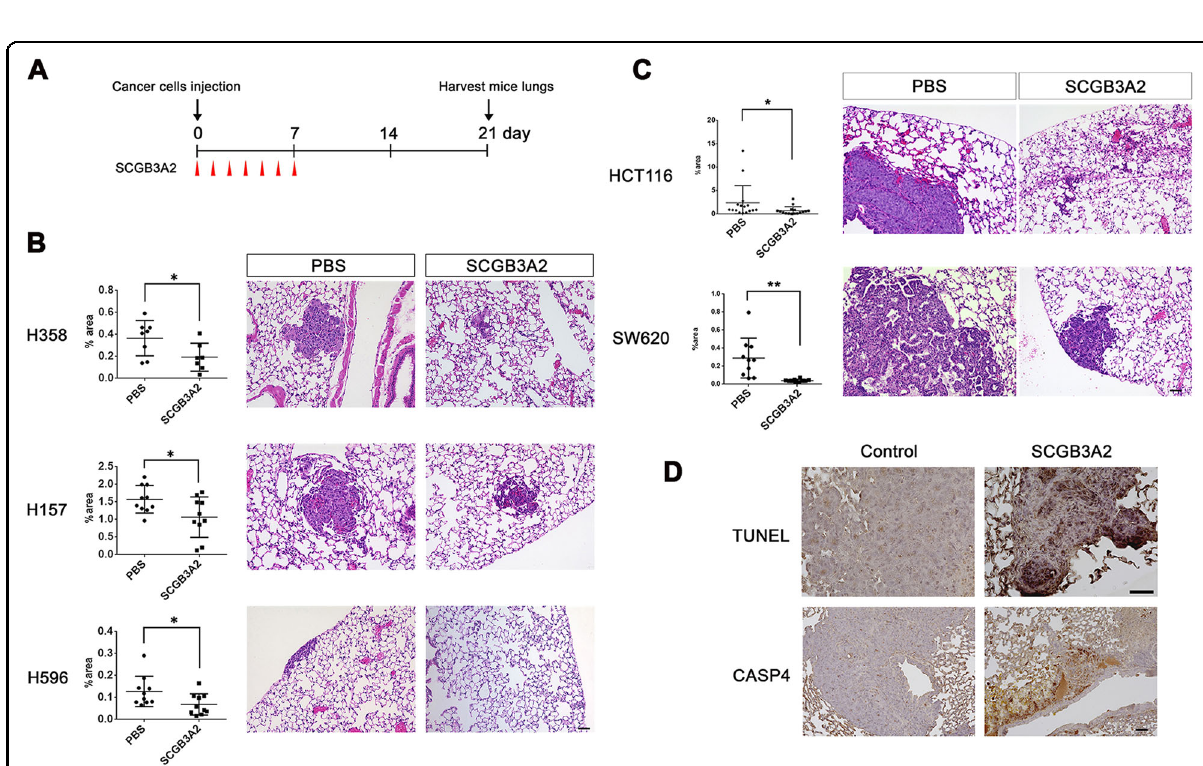
Fig. 4 Inhibition of human cancer cells growth in vivo by SCGB3A2. A Human cancer cells intravenous metastasis mouse model scheme. B , C Summary for the total tumor area of lung inoculated with human NSCLCs; NCI-H358, H157, H596 ( B ), and human colorectal cancer cells; HCT116 and SW620 ( C ). Averages ± SD from N = 5 per group for lung cancer cells and SW620, N = 8 for HCT116. Two sections at different positions of tissue per mouse were used for the analysis. * P < 0.05, ** P < 0.01. Representative HE staining images of tissue sections from each PBS or SCGB3A2 administration group are shown on the right. Bar = 50 μ m. D Representative images of TUNEL and CASP4 staining of lung sections of lung metastasized HCT116 cells from control (PBS) and SCGB3A2 administered mice. Three independent tissue samples were evaluated for each group, and similar results were obtained. Bar = 50 μ